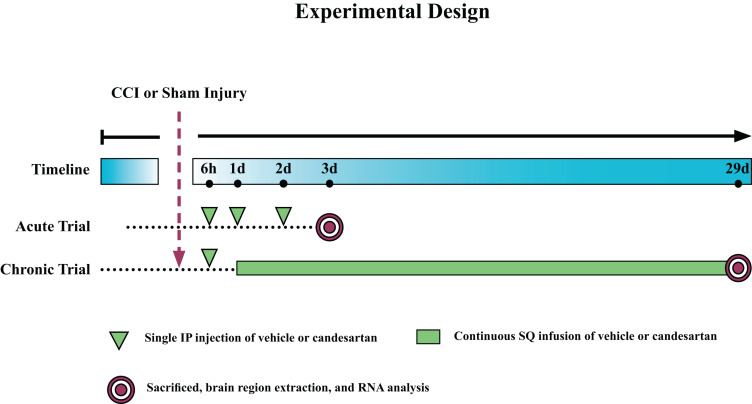
Experimental Design. Mice were subjected to controlled cortical impact (CCI) or sham injury and sacrificed at either 3 days post-injury (dpi) (acute) or 29 dpi (chronic). Mice in the acute trial received three 0.1 mg/kg intraperitoneal (IP) injections of candesartan or vehicle at 6, 24, and 48 h post-injury. Mice in the chronic trial received an initial dose of 0.1 mg/kg candesartan or vehicle at 6 h post-injury and then at 1 dpi, were implanted with osmotic pumps with continuous SQ infusion of candesartan or vehicle (0.1 mg/kg/day) until sacrifice. Brains were removed and the hippocampus, thalamus, and hypothalamus dissected, and RNA isolated from these regions.